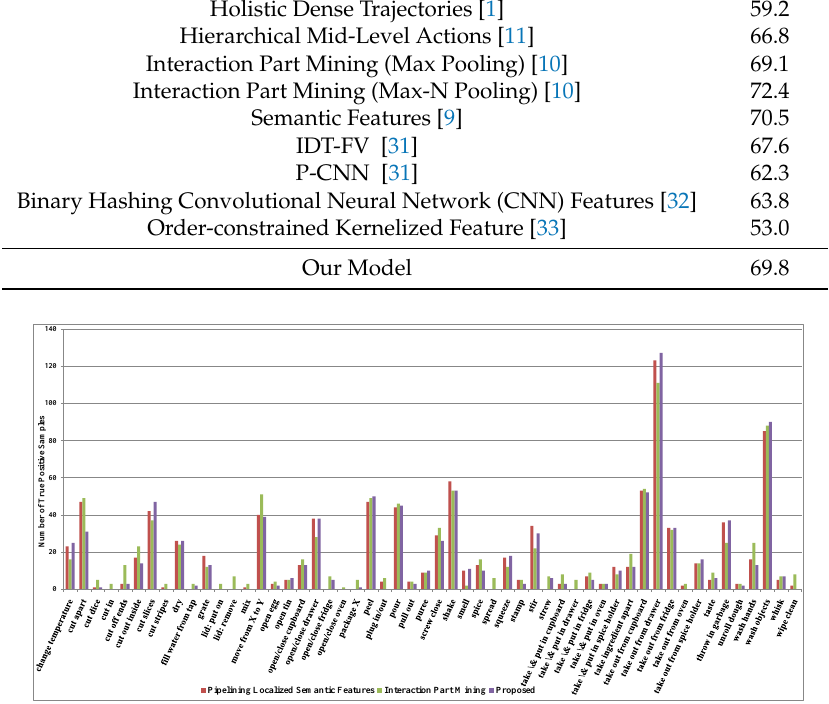
Figure 6. Per-class classification performance comparison on the MPII cooking database. We compare our method with the Semantic Features and Interaction Part Mining (Max-N Pooling) methods in terms of the number of true positive